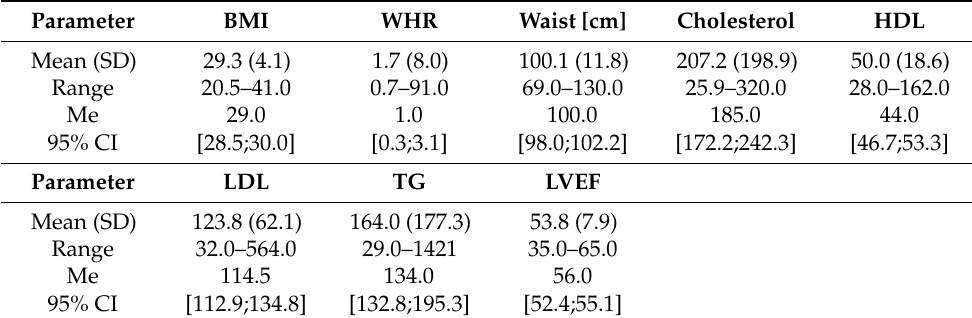
Table 2. Characteristics of the examined group in terms of BMI, WHR, waist circumference, total cholesterol, HDL, LDL, TG, and